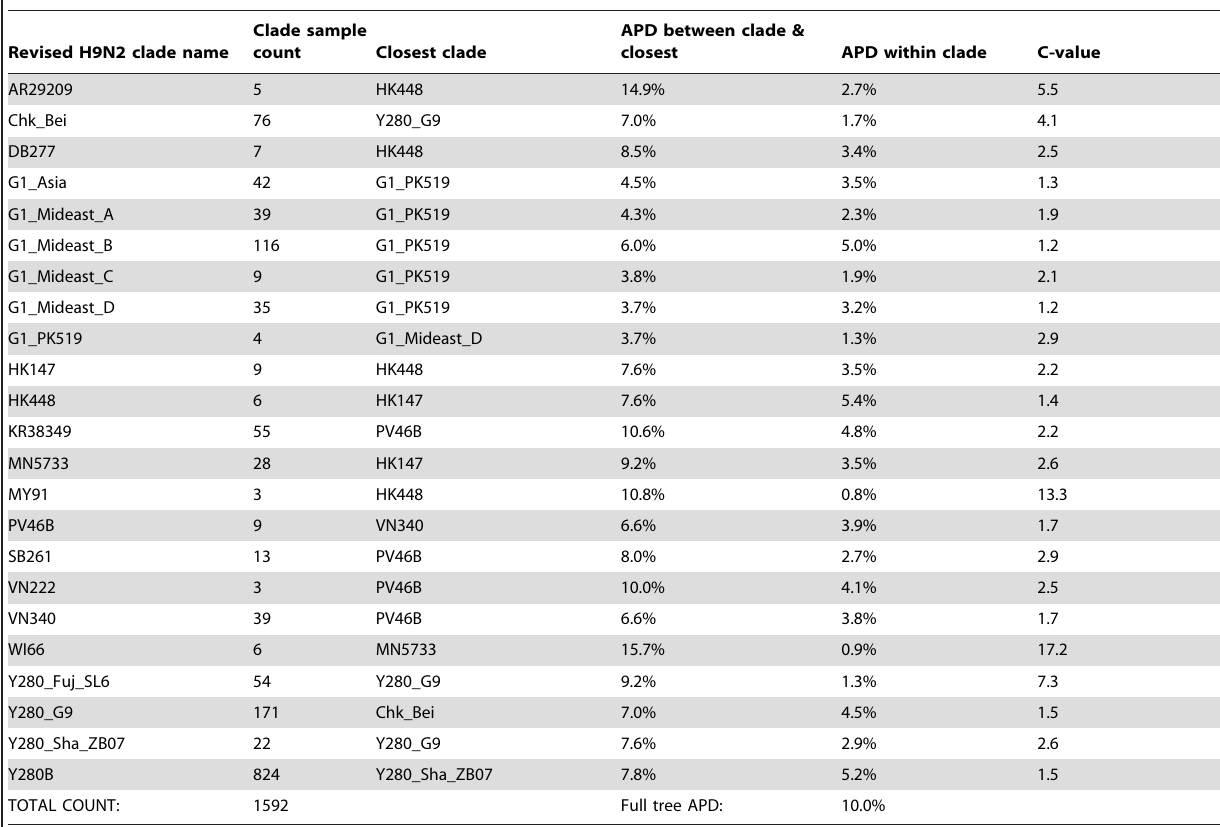
Table 2. Revised 2012 H9N2 nomenclature.